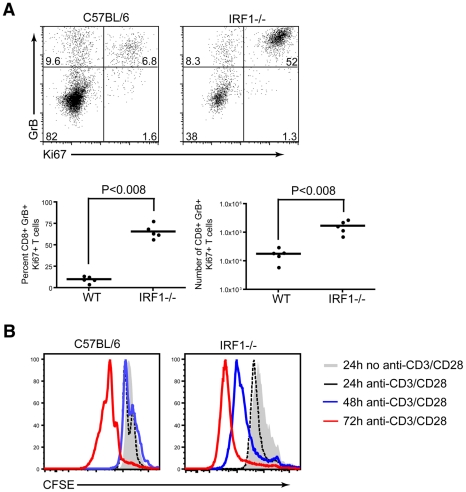
Proliferative capacity of IRF-1
-/- CD8+ T cells.
A. Assessment of CD8+ T cell proliferative capacity at day 8 after WNV infection. CD8+ T cells from wild type or IRF-1
-/- mice were stained for CD8b, intracellular GrB and intranuclear Ki-67, and analyzed by flow cytometry. Representative flow cytometry dot plots gated on CD8b+ cells, showing the percentage of antigen-specific proliferating CD8b+GrB+Ki-67+ cells. Graphical summary of the percentage and total number of CD8b+GrB+Ki-67+ T cells. A scatterplot of the data is shown and was generated from two independent experiments with 5 wild type or IRF-1
-/- mice. B. In vitro proliferative capacity of purified naïve CD8+ T cells. Representative flow cytometry profiles of carboxyfluorescein diacetate dilution from CD8b+ T cells stimulated with plate bound anti-CD3e (1 µM) and anti-CD28 (1 µM) at three time points. The data are representative of one individual mouse per group and the experiment was repeated three independent times with two mice per group each time.